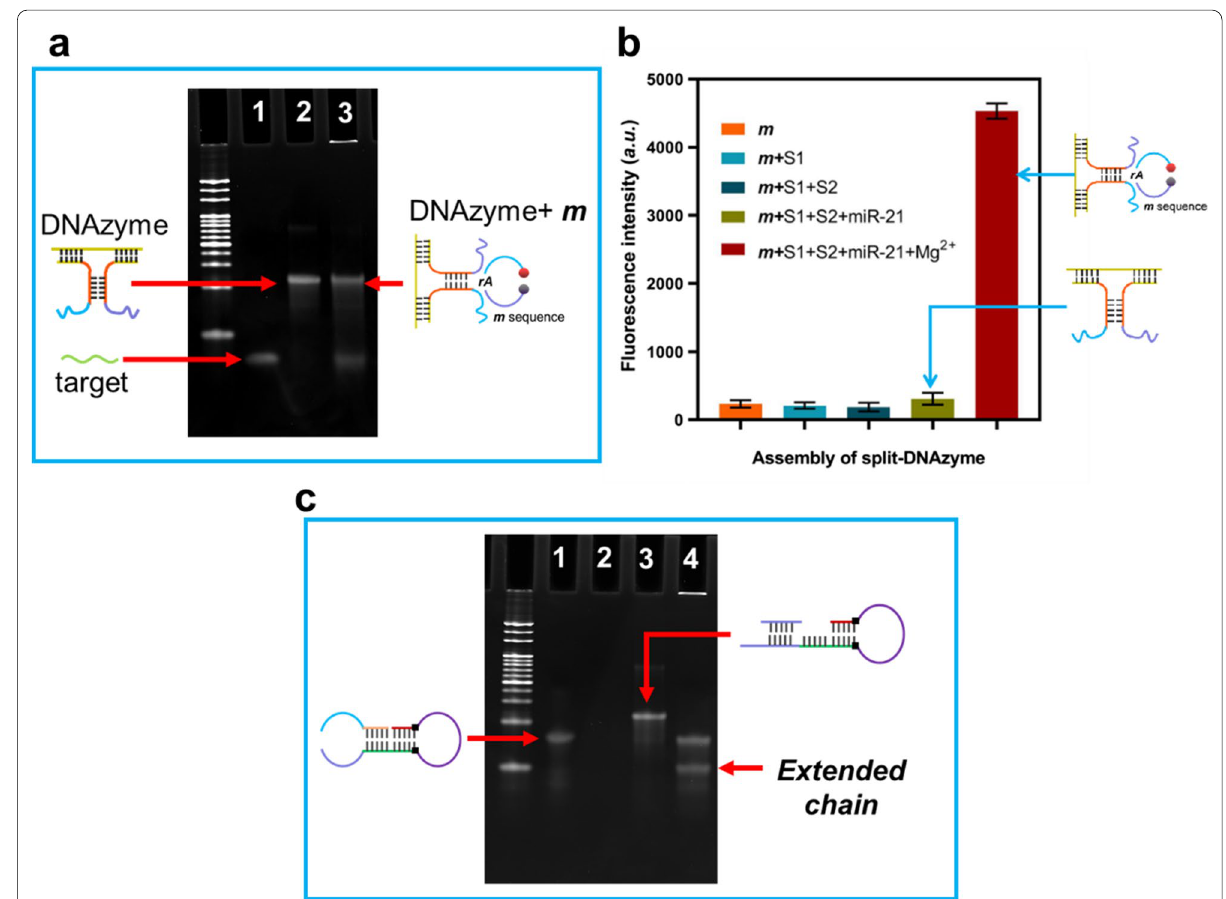
Fig. 2 Investigation of assembly of split-DNAzyme and feasibility of PER. a PAGE analysis of the assembly of split-DNAzyme; b Fluorescence intensity of the m sequences when they were incubated with different combination of S1 (split-DNAzyme-1), S2 (split-DNAzyme-2), miRNA-21 and Mg 2 + . c PAGE analysis of the PER